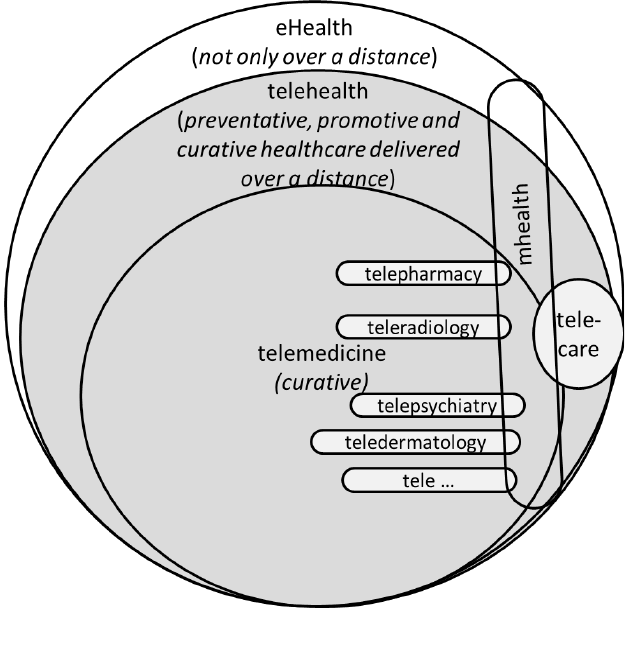
Figure 1. Telemedicine, ehealth, telehealth, telecare and